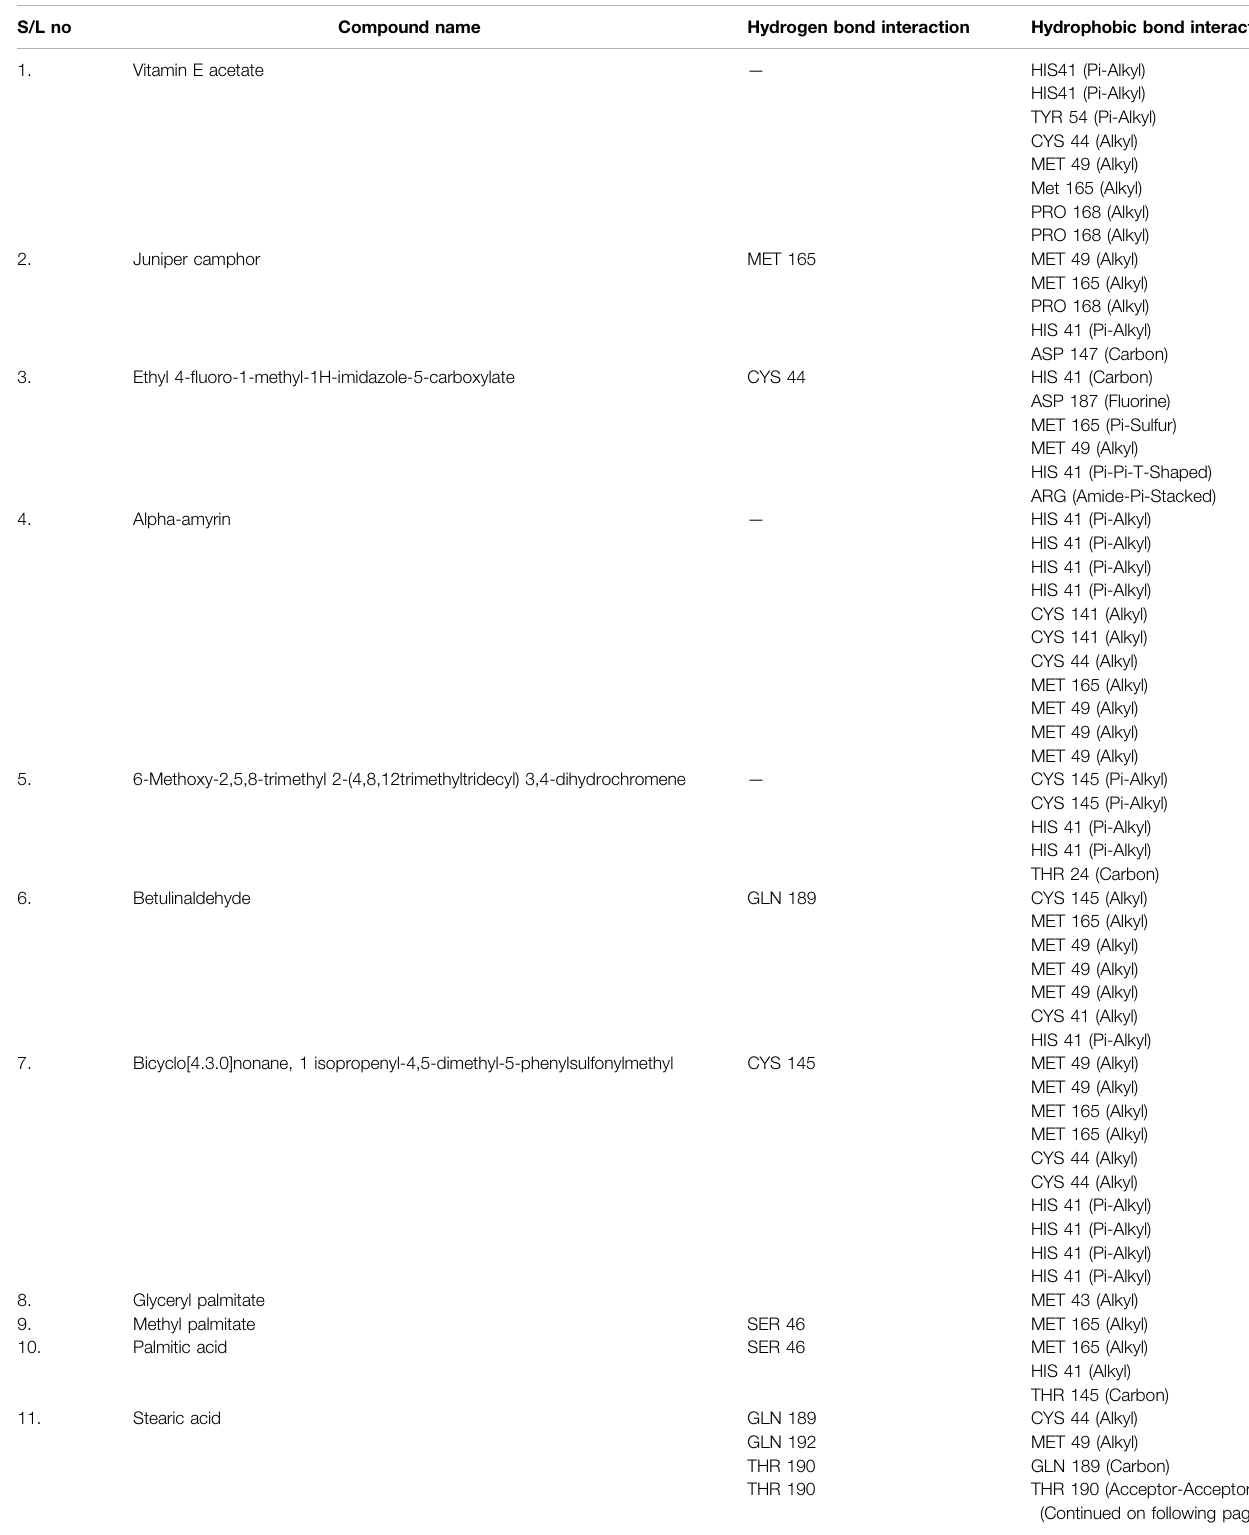
TABLE 3 | Ligand interactions with amino acids of the protein active